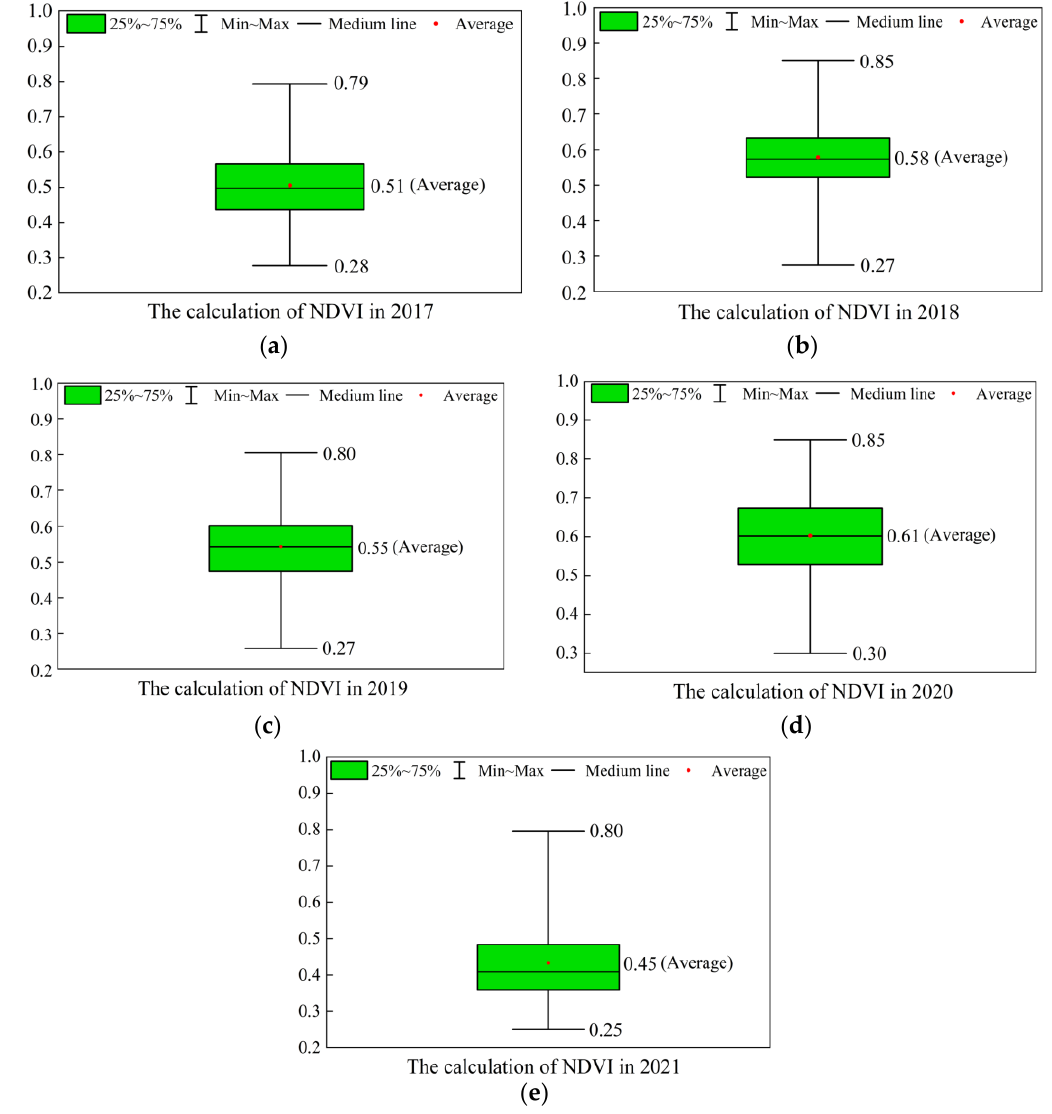
Figure 6. The NDVI distribution in each year: ( a ) 2017; ( b ) 2018; ( c ) 2019; ( d ) 2020; ( e ) 2021.